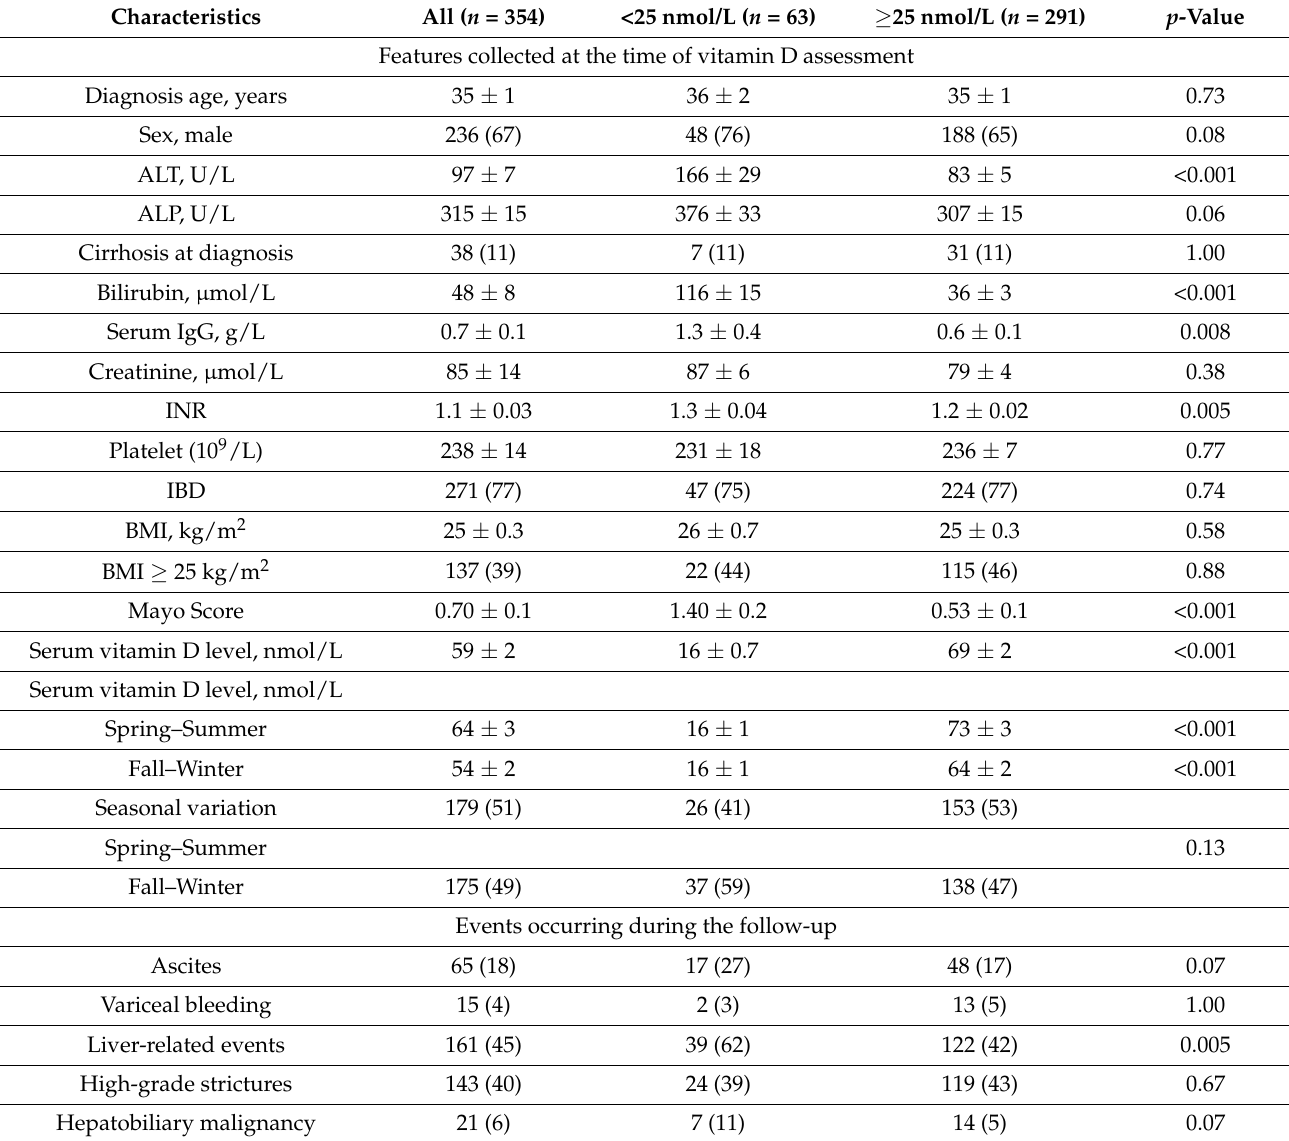
Table 1. Clinical and Biochemical Characteristics Related to Vitamin D Deficiency in